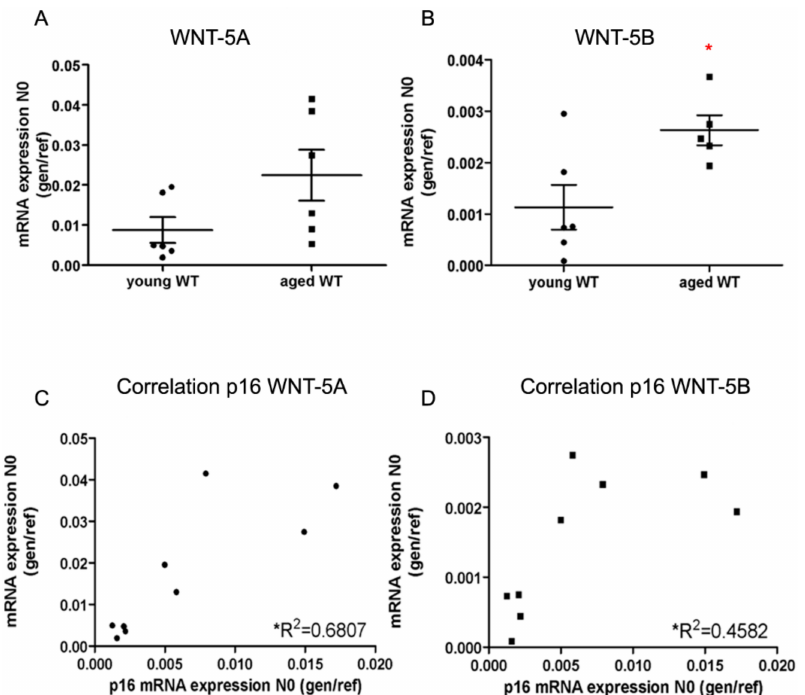
Figure 1. WNT-5A and WNT-5B increased in old mice. ( A ) The gene expression level of WNT-5A in young wild type mice (left) and aged mice (right). ( B ) The gene expression level of WNT-5B in young wild type mice (left) and aged mice (right). ( C ) Significant correlation between WNT-5A and p16 mRNA expression. ( D ) Significant correlation between WNT-5B and p16 mRNA expression. Data are expressed as mean ± SEM, * p <